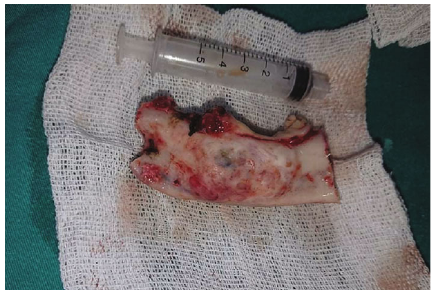
Figure 2: Excised bone.